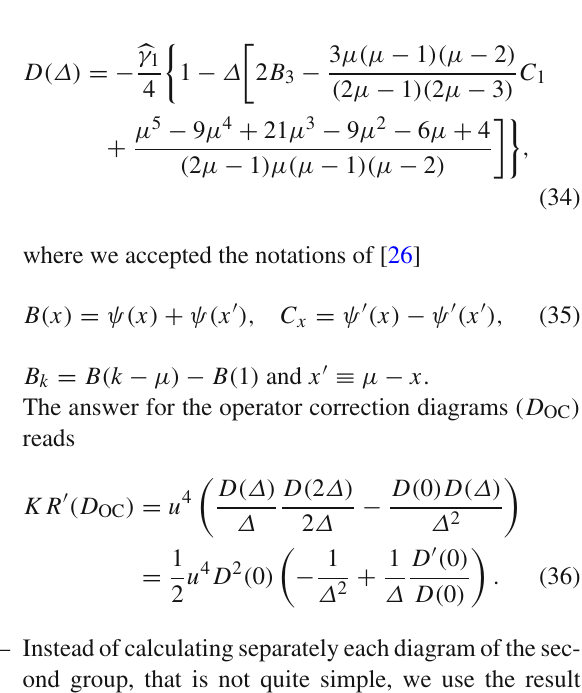
Fig. 4 Operator vertex correction